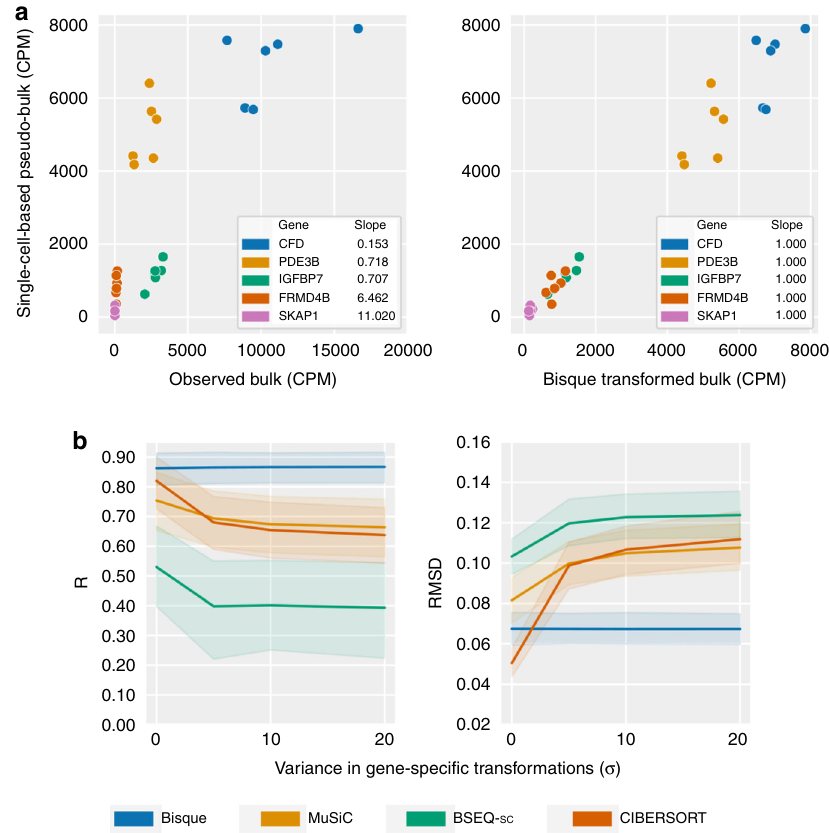
Fig. 2 The effect of discrepancies between a single-cell-based reference and bulk expression on decomposition. a Observed discrepancies in real data between single-nucleus and bulk expression for selected marker genes ( left ) for six individuals. Each color corresponds to a gene. On the left, observed bulk expression on the x axis is plotted against the pseudo-bulk expression on the y axis, where pseudo-bulk expression is calculated by summing the single- cell-based reference with cell proportions as weights. On the right, the Bisque transformation of bulk expression is on the x axis. Bisque recovers a one-to- one relationship by transforming the bulk expression for improved decomposition accuracy ( right ). b Simulation of bulk expression for six individuals based on true adipose snRNA-seq data with increasing gene-speci fi c differences. These differences are modeled as a linear transformation of the summed snRNA-seq counts with coef fi cient and intercept sampled from half-normal distributions with parameter as indicated on the x axis. At σ = 0, the simulated bulk is simply the sum of the observed single-cell read counts. Performance on y axis measured in global Pearson correlation ( R ) ( left ) and root-mean squared deviation (RMSD) ( right ). Shaded regions indicate 95% con fi dence intervals based on bootstrapping with central lines indicating the mean observed value. Bisque remains robust to increasing gene-speci fi c variation between single-cell and bulk expression levels. Source data are provided as a Source Data fi le. Table 2 Leave-one-out cross-validation in subcutaneous adipose using 6 samples with snRNA-seq and bulk RNA-seq data available.